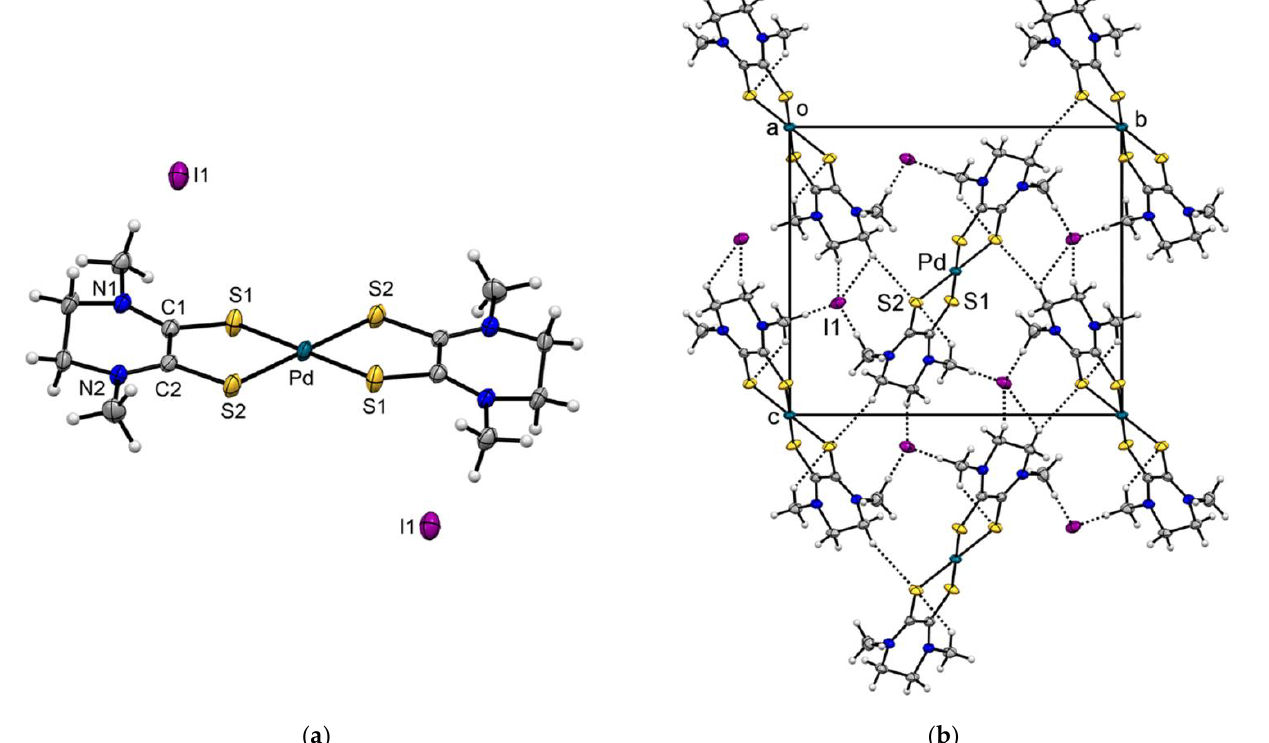
Figure 2. ( a ) Molecular structure of complex [Pd(Me 2 pipdt) 2 ](I) 2 ( 2a ) with thermal ellipsoids plotted at the 50% probability level. ( b ) Portion of the crystal packing, showing intermolecular interactions as dashed bonds.